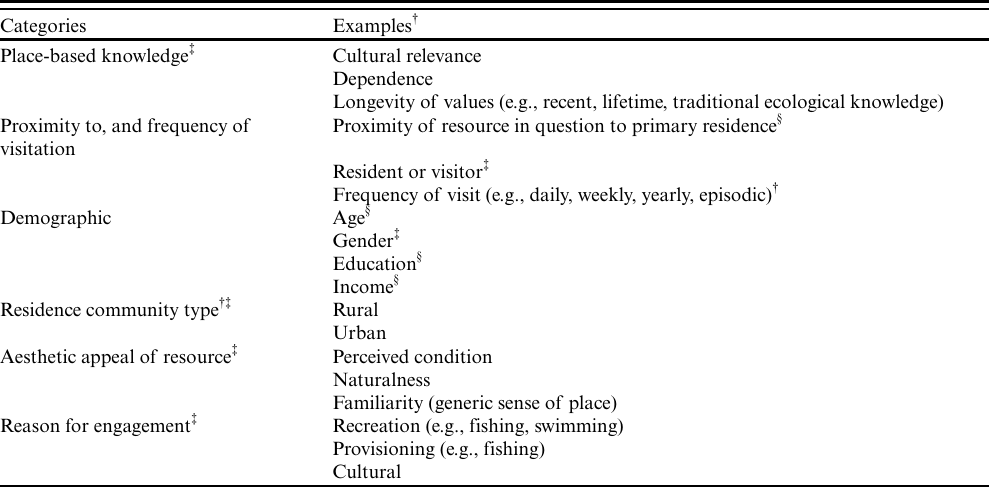
Table 1 . Factor categories influencing social demands of aquatic ecosystems, with examples of potential first and second level